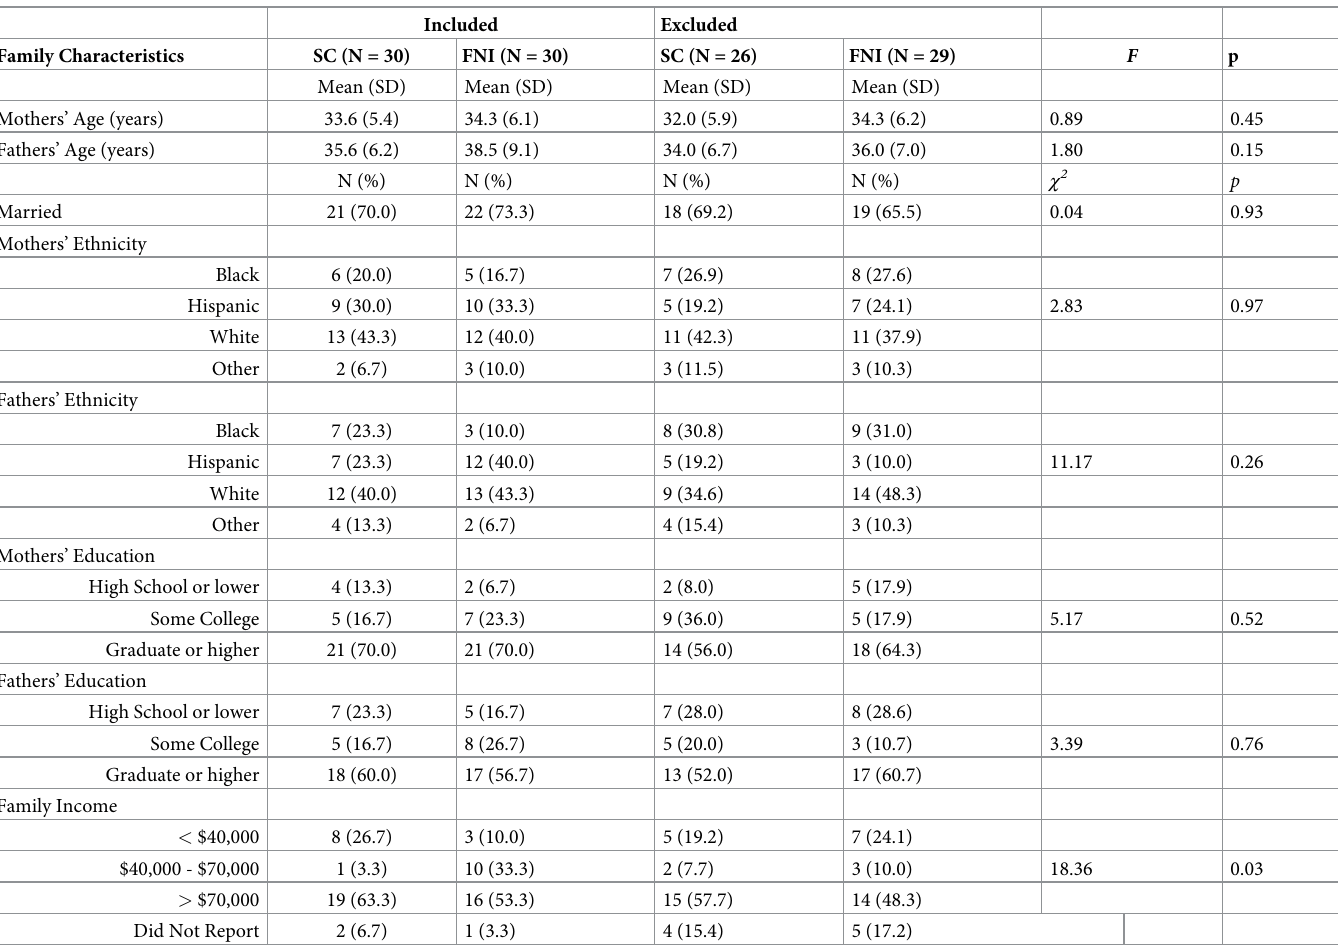
Table 1. Demographic variables of mothers, fathers and families who were included (n = 60) or not included in the current analyses (n = 55).